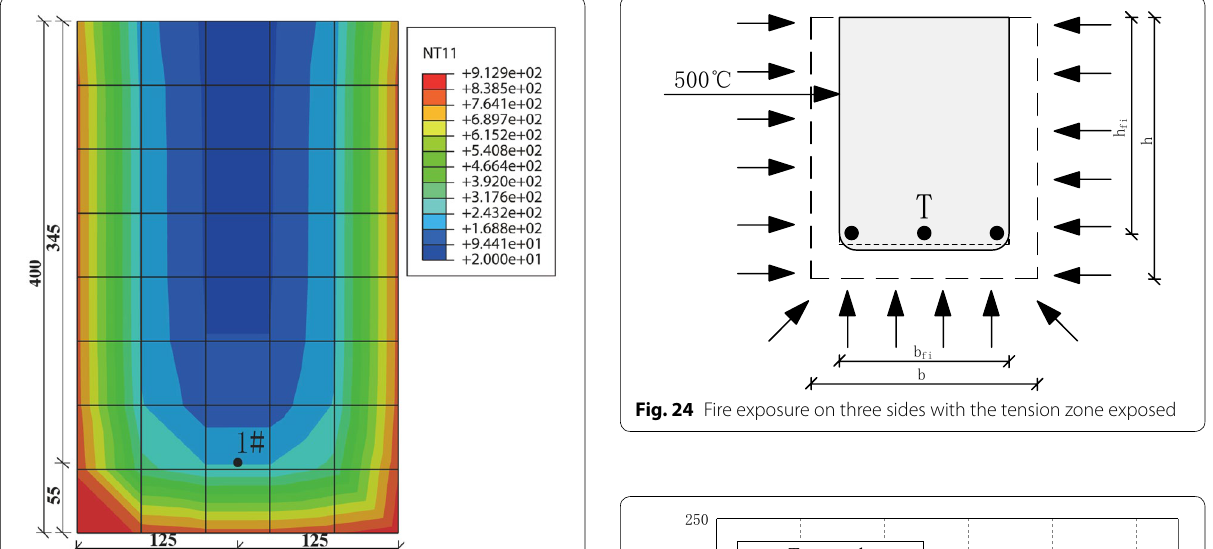
Test result Simulation result